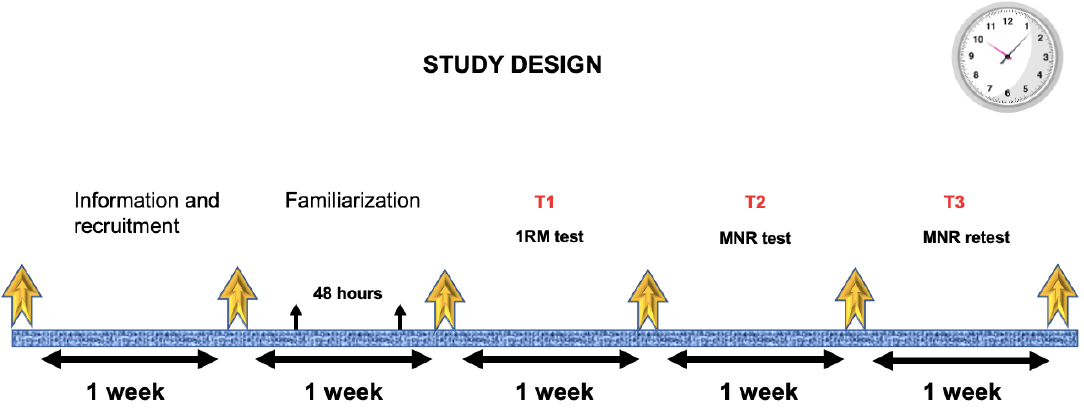
Figure 1. Study design. MNR = maximum numbers of repetitions.